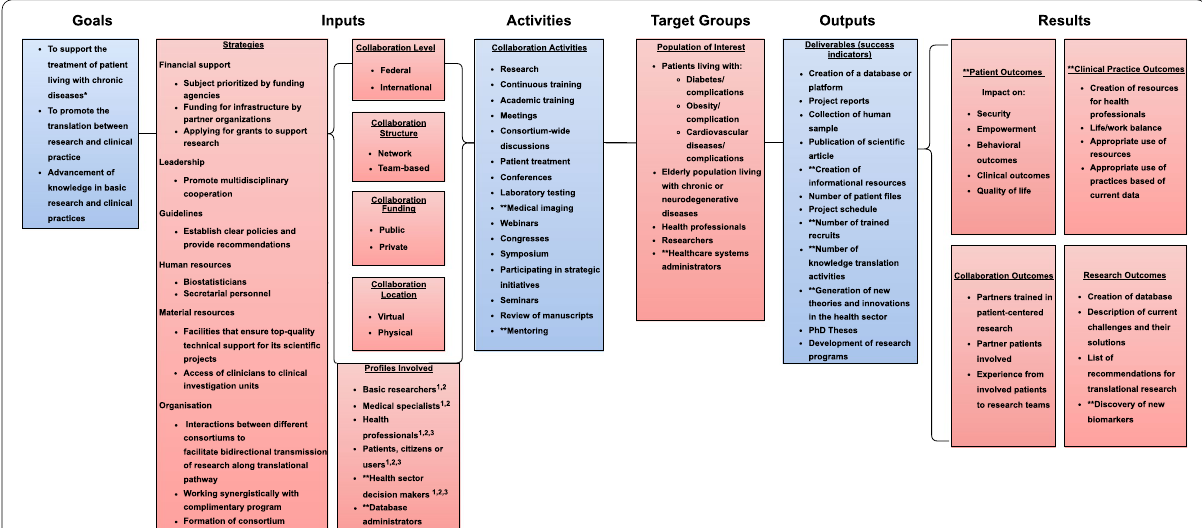
Fig. 2 Logic model for a global translational research collaboration model. * Diabetes, obesity, cardiovascular diseases, and their complications, and elderly population living with chronic or neurodegenerative disease. ** Elements that were not mentioned in the reviewed literature but were identified by experts in the field. 1,2,3 indicates profiles involved in the 1 st , 2 nd and 3 rd pillars of